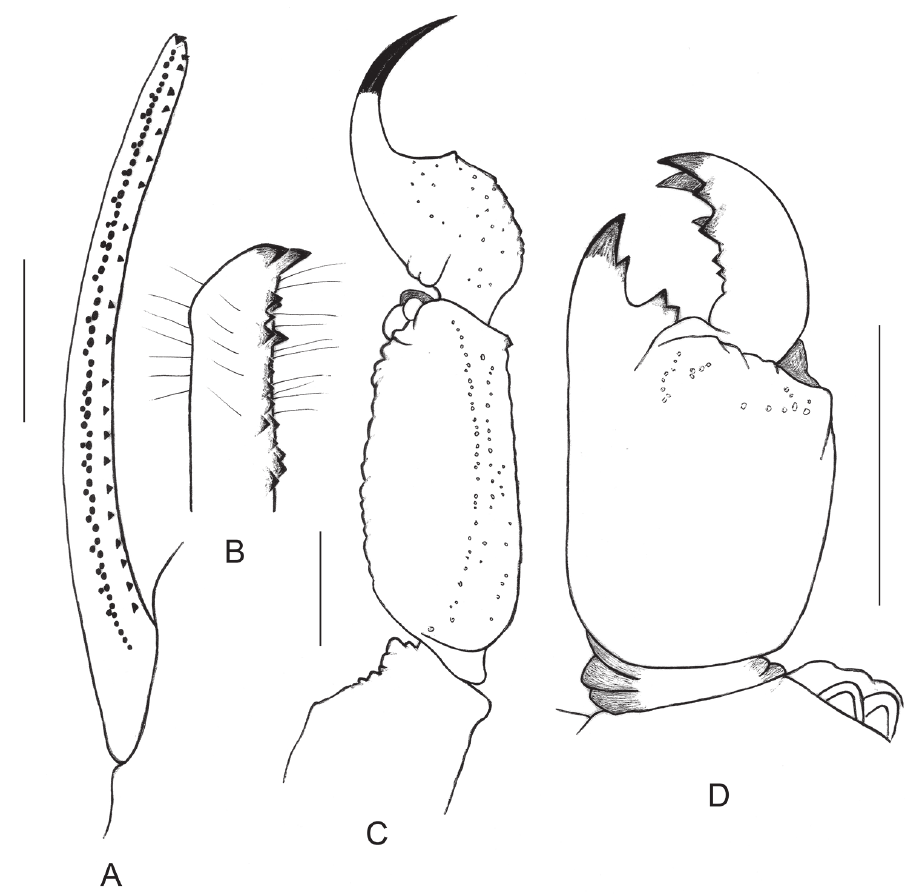
Figure 5. Physoctonus amazonicus sp. n., female holotype. A Cutting edge of chela movable finger B Idem, ex- tremity in detail C Metasomal segment V and telson, lateral aspect D Chelicera, dorsal aspect. Scale bars: 1 mm. Description. Based on female holotype. Measurements after the description. Colouration. Basically yellow strongly marked with brownish spots. Prosoma: carapace yellow with a brownish inverted triangle covering the anterior margin of carapace and well-marked brownish spots over the lateral edges; eyes surrounded with black pigment. Mesosoma: tergites yellow with a median longitudinal spot which be- comes confluent on III to VI; lateral edges equally spot as for carapace. Metasomal segments I to IV yellow; V reddish-yellow to reddish-brown; segments II to V strongly infuscate ventrally; carinae dark. Vesicle of same colour as segment V; aculeus yellow at the base and reddish on tip. Venter yellow; genital operculum and pectines pale yellow. Chelicerae yellow with a brownish thread; fingers yellow with reddish teeth. Pedipalps yellow with intense but diffused brownish spots; carinae and granulations on the edge of fingers reddish. Legs yellow with intense diffused brownish